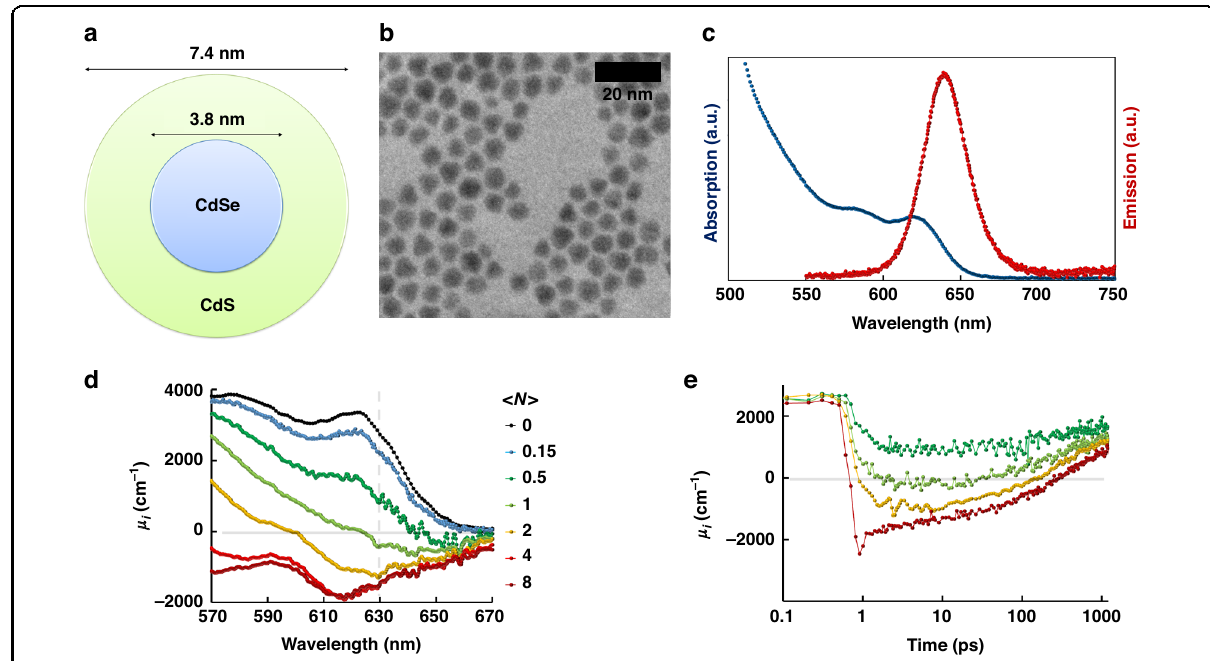
Fig. 1 Properties of the synthesized QDs. a Schematic structure of a core/shell CdSe/CdS QD. b TEM image. c Absorption spectrum (blue) and photoluminescence spectrum (red) of the QDs dispersed in toluene. d QD absorption ( μ i > 0) or gain ( μ i < 0) spectrum as a function of the excitation level < N > at 3 ps after the pulse excitation. e Corresponding time-dependency of the gain spectrum at a fi xed probe wavelength of 630